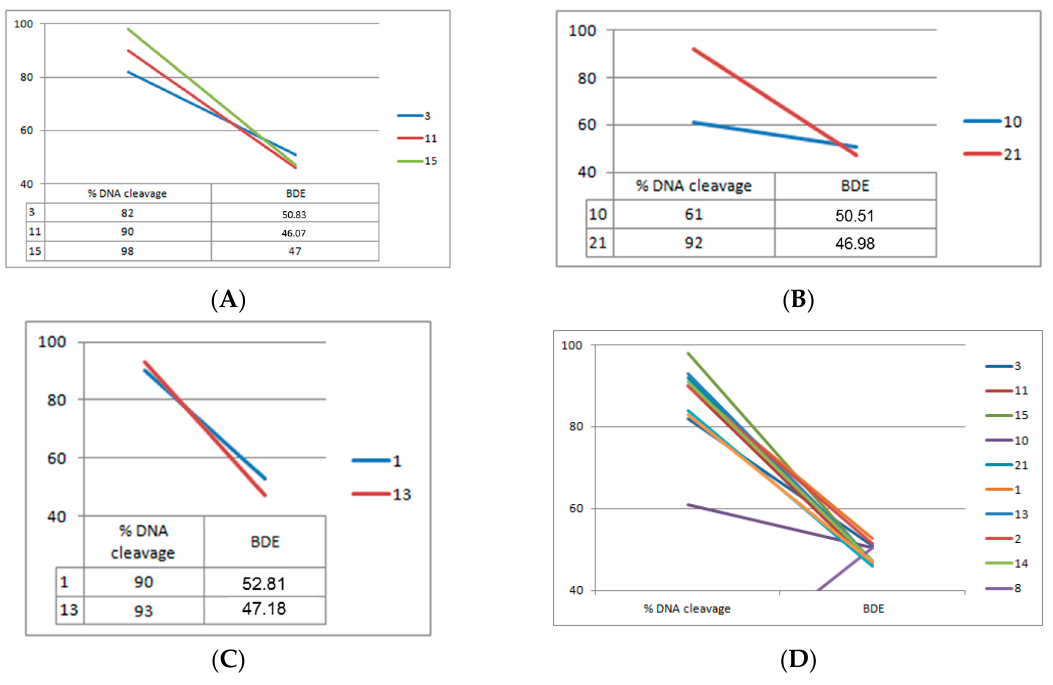
Figure 5. Graphical correlations between BDE and % DNA photo-cleavage. ( A ) Compounds bearing p -pyridine oxime substituent and p -nitro-phenyl ester conjugate in amidoxime, ethanone oxime and aldoxime ( 3 , 11 and 15 , respectively); ( B ) Compounds bearing p -nitro-phenyl oxime substituent and p -pyridine ester conjugate in amidoxime and aldoxime ( 10 and 21 , respectively); ( C ) Compounds bearing o -pyridine oxime substituent and p -nitro-phenyl ester conjugate in amidoxime and aldoxime ( 1 and 13 , respectively); ( D ) All DNA photo-cleaving compounds.